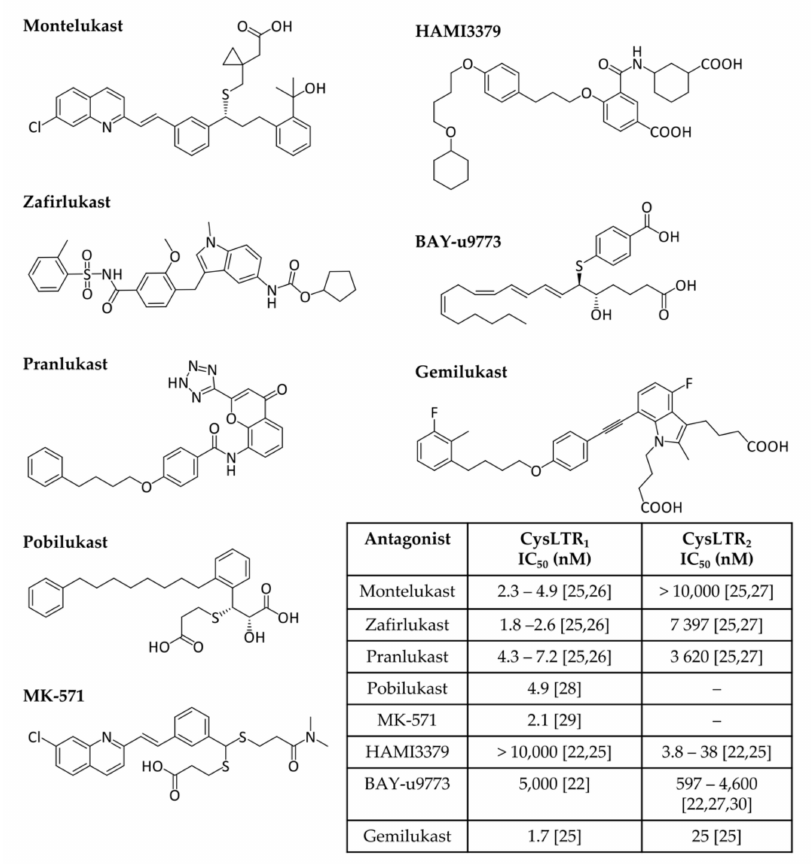
Figure 2. Cysteinyl leukotrienes receptor antagonists. CysLTR 1 antagonists (montelukast, zafir- lukast, pranlukast, pobilukast, and MK571), CysLTR 2 antagonists (HAMI3379) and dual antagonists (BAY-u9773 and gemilukast) are shown. Experimental IC 50 values available from the literature are also given in the inset table